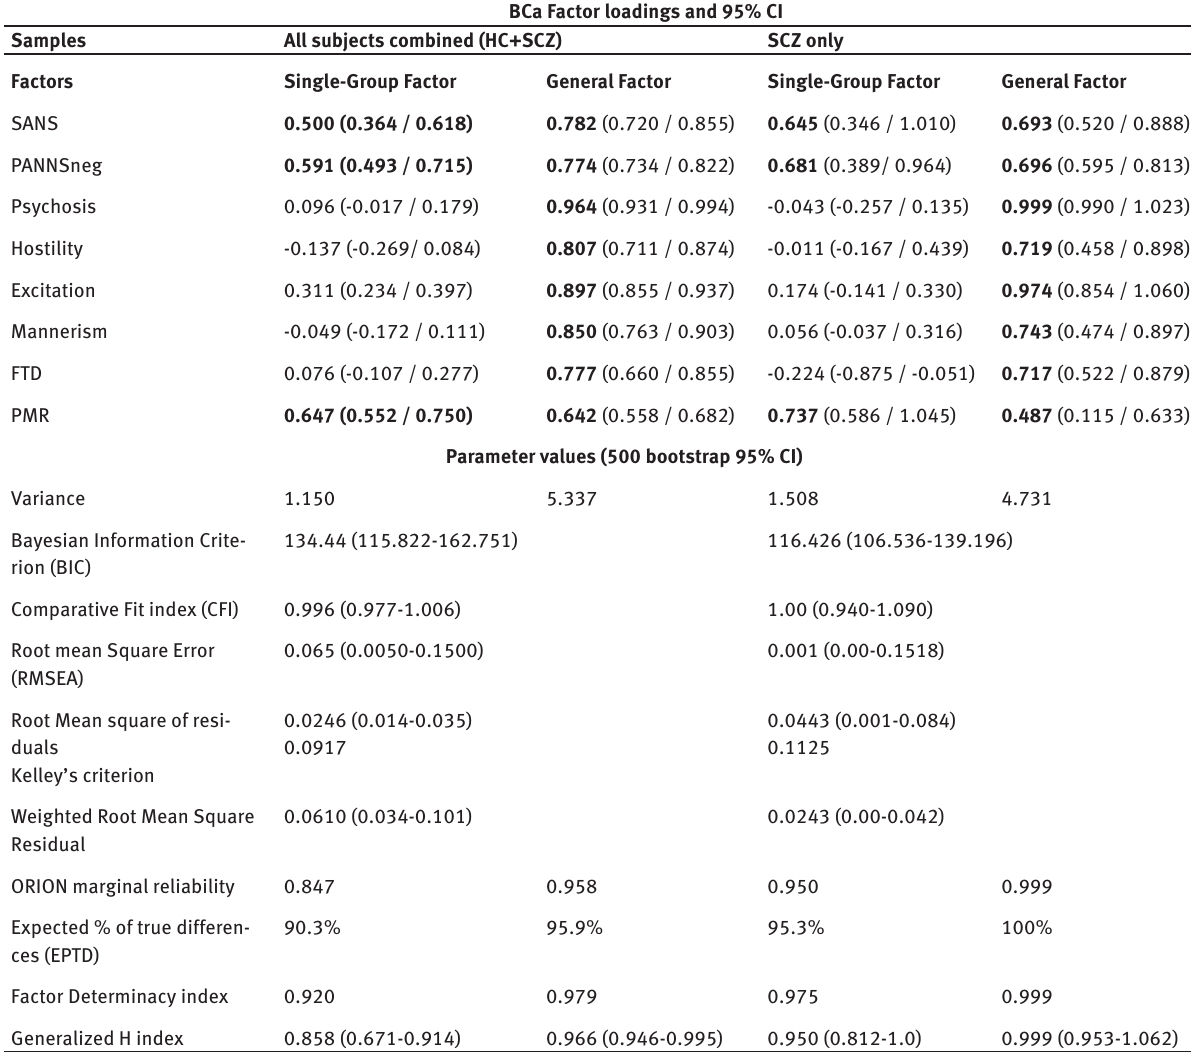
Table 4: Results of Pure Exploratory Bifactor analysis, bias-corrected and accelerated (BCa) bootstrap with 95% confidence intervals